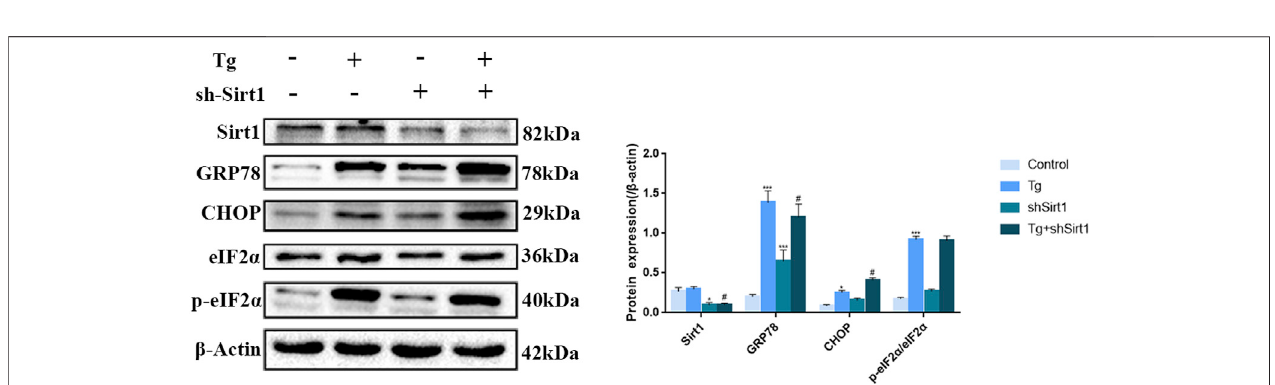
FIGURE4| Effectsofsh-SIRT1 ontheprotein levelsofCHOP, GRP78,eIF2 α andp-eIF2 α inTg-induced Caco-2cells.Dataarepresented asthemean±SEM( n = 3). Statistically signi fi cant differences are indicated; * p < 0.05, ** p < 0.01, *** p < 0.001, signi fi cantly different from control group. # p < 0.05, signi fi cantly different from Tg